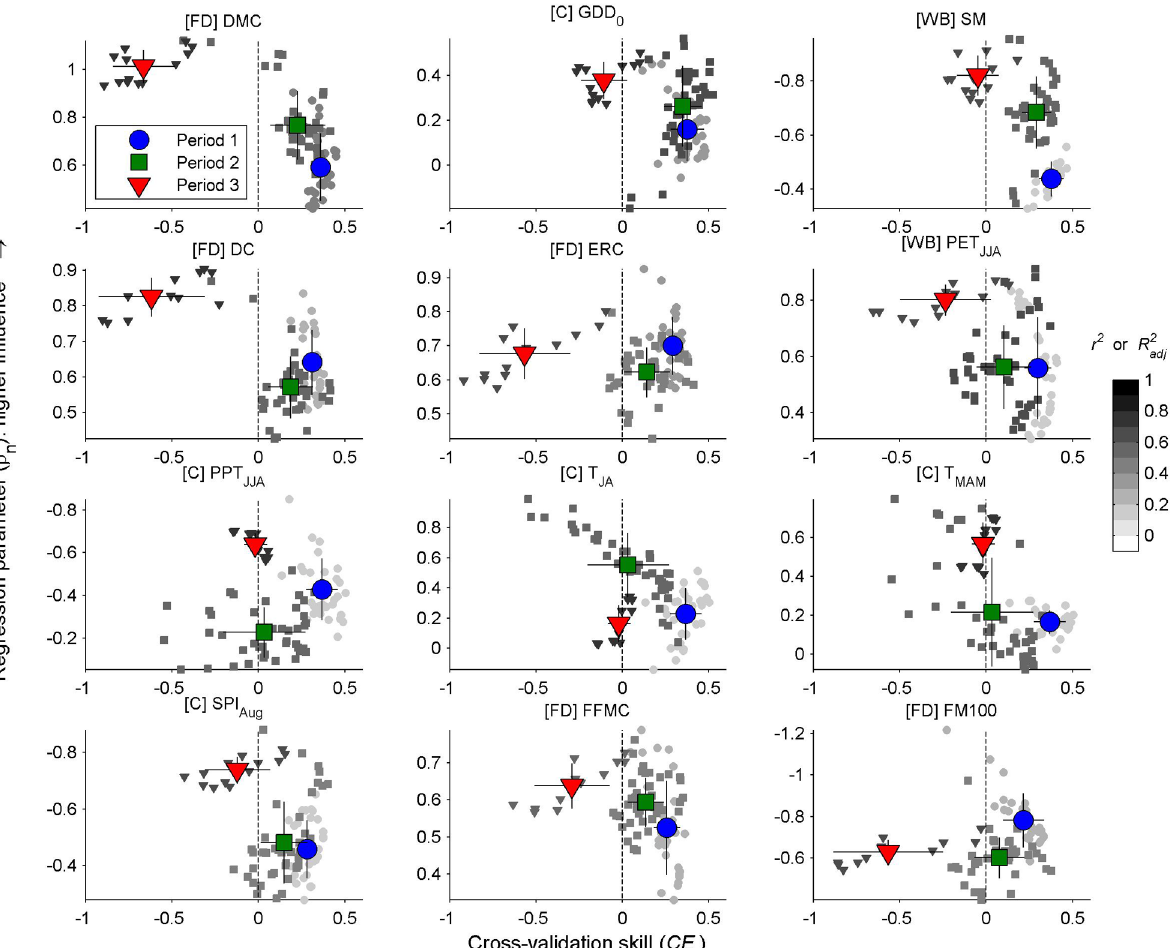
Fig 7. Cross-validation skill, model parameters, and strength of fire-climate relationships for top metrics. Small symbols represent cross-validation skill and the regression parameter for 21-yr calibration windows, stratified by Period 1 (1902 – 1942, circles), Period 2 (1943 – 1984, squares) and Period 3 (1984 – 2008, triangles). The grayscale of each small symbol represents r 2 or R 2 adj for that window (as in Fig 5B), and large symbols represent the centroid of all values within each period, +/- one standard deviation. Regression parameters represent the slope of the model, β 1 , for single-variable regression models. GDD 0 represents β 2 from the combined DMC, GDD 0 model, while PPT JJA , T JA , and T MAM represent β 1, β 2 , and β 3 from the three-variable model, respectively. Parameter values indicated the unit (standard deviation) change in log-transformed area burned for a unit (standard deviation) change in the predictor variable: more extreme values indicated a greater influence on annual area burned. Values below the dashed vertical line on the x axis ( CE = 0) lack cross-validation skill. Metrics are ordered from upper left to bottom right based on the overall model score (Table